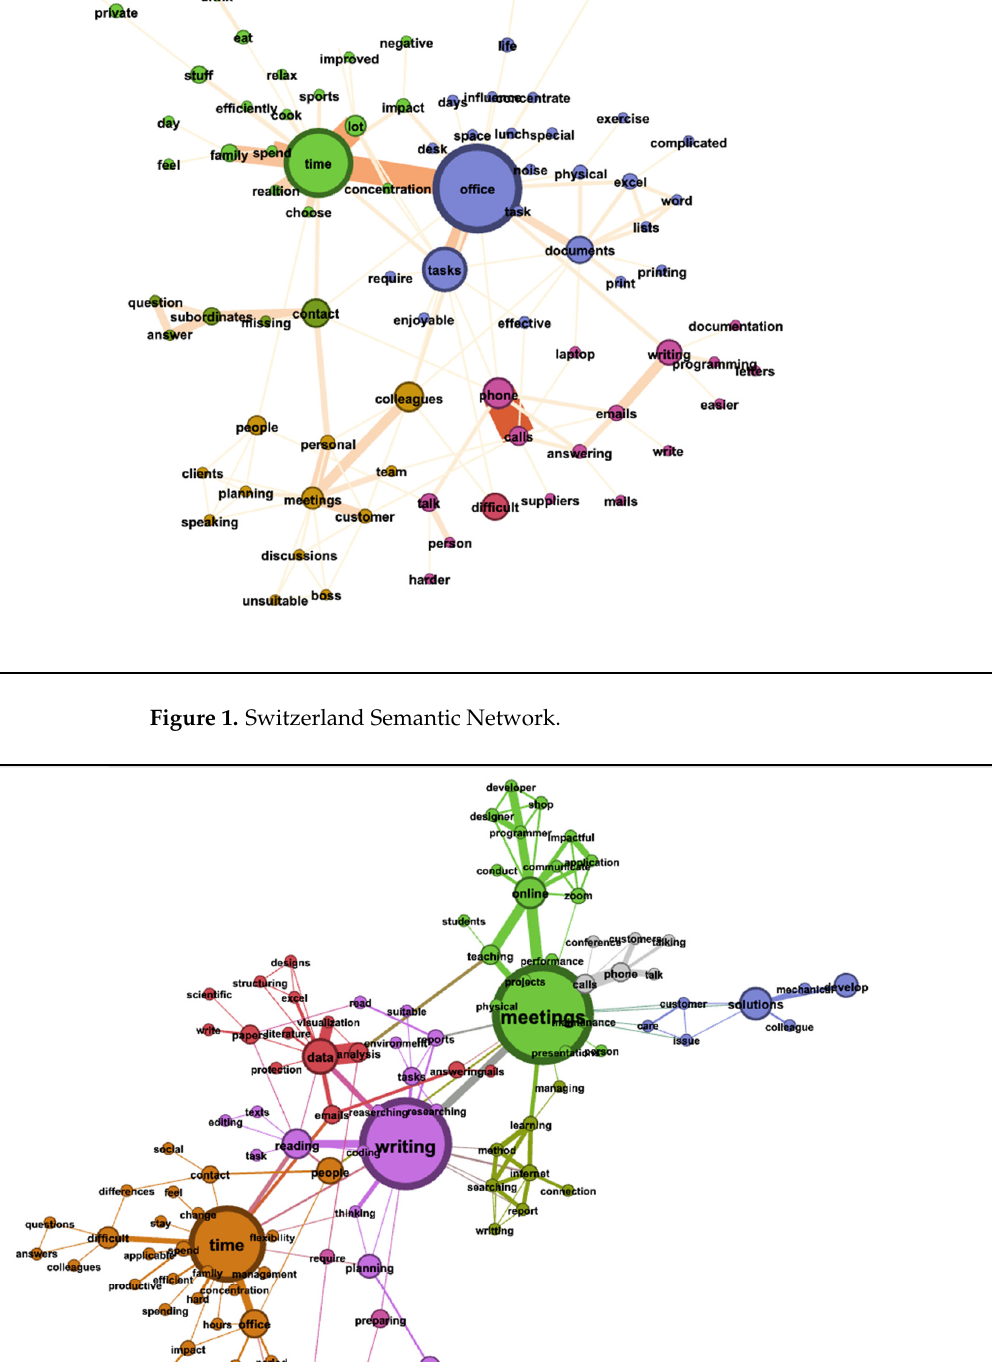
Figure 3. United Kingdom Semantic Network.